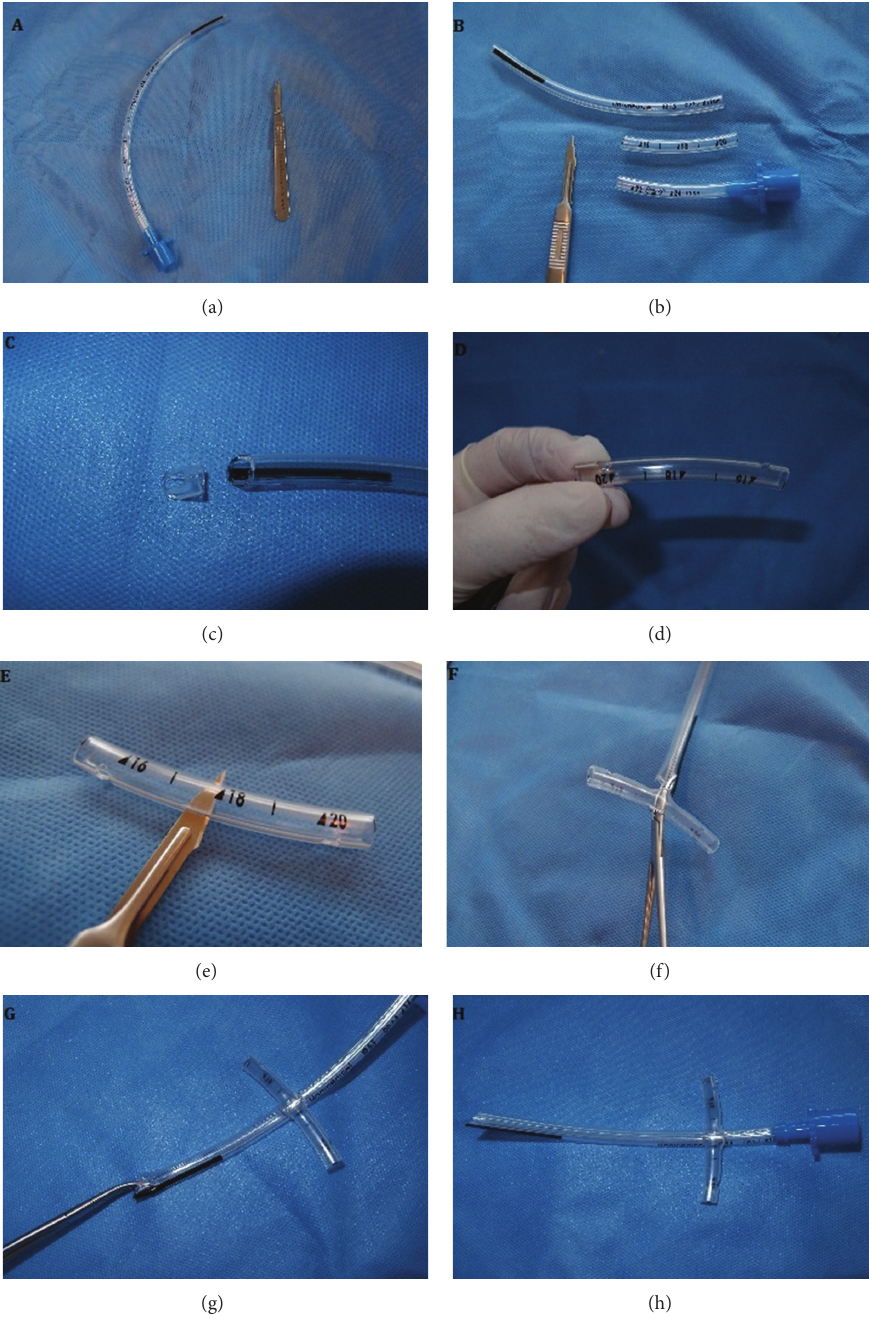
Figure3:Customizedtracheostomycannula.Using1E-tubeandblade(a),dividetheE-tubeinto3segments(b),longestoneisformaintaining the airway, and the other is used for stent fixation. The beveled tip and side hole are removed. (c) Two holes are placed at opposing sides of upper end for string attachment. (d) Two holes are then made (front and back) at mid-section, allowing the curved tube to approximate the patient’s neck contours. (e) The airway tube is ultimately inserted and fixed, leaving an appropriate length distally and a 5cm excess at the proximal end. (f), (g) Both tubes (airway and fixation) together are finally inserted and secured with nylon suture (2.0 or 3.0)